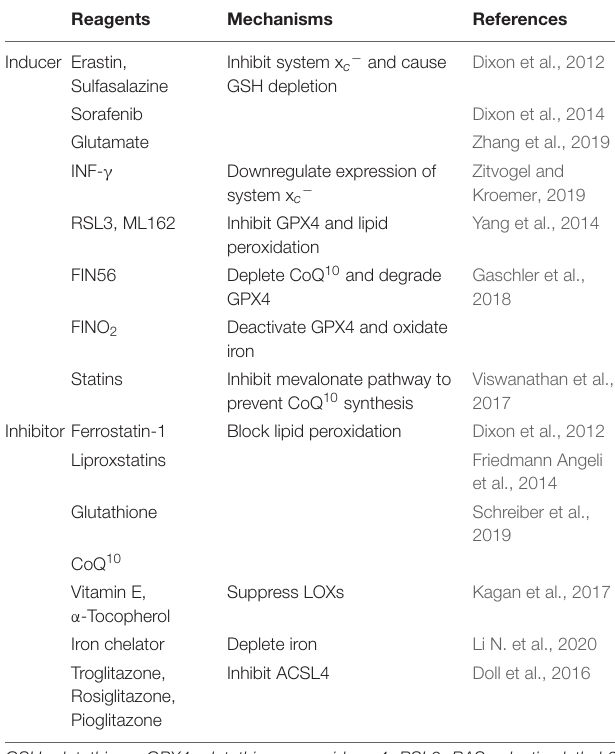
TABLE 2 | Common inducers and inhibitors of ferroptosis and their functioning